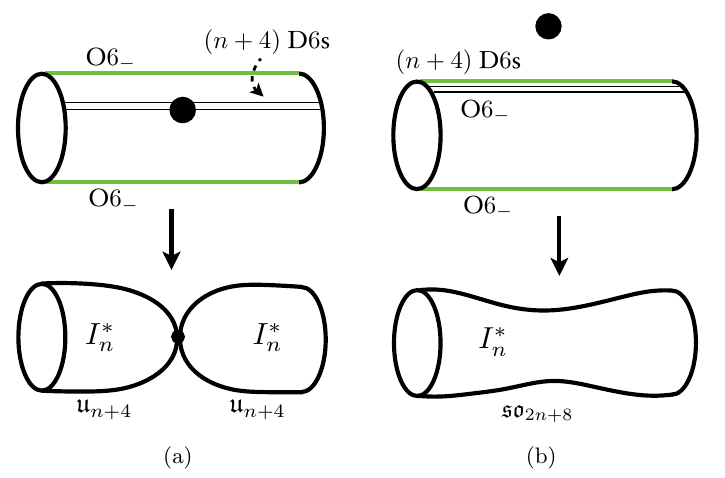
D m +4 { n +4 conformal matter. (a) reproduces (2.12);